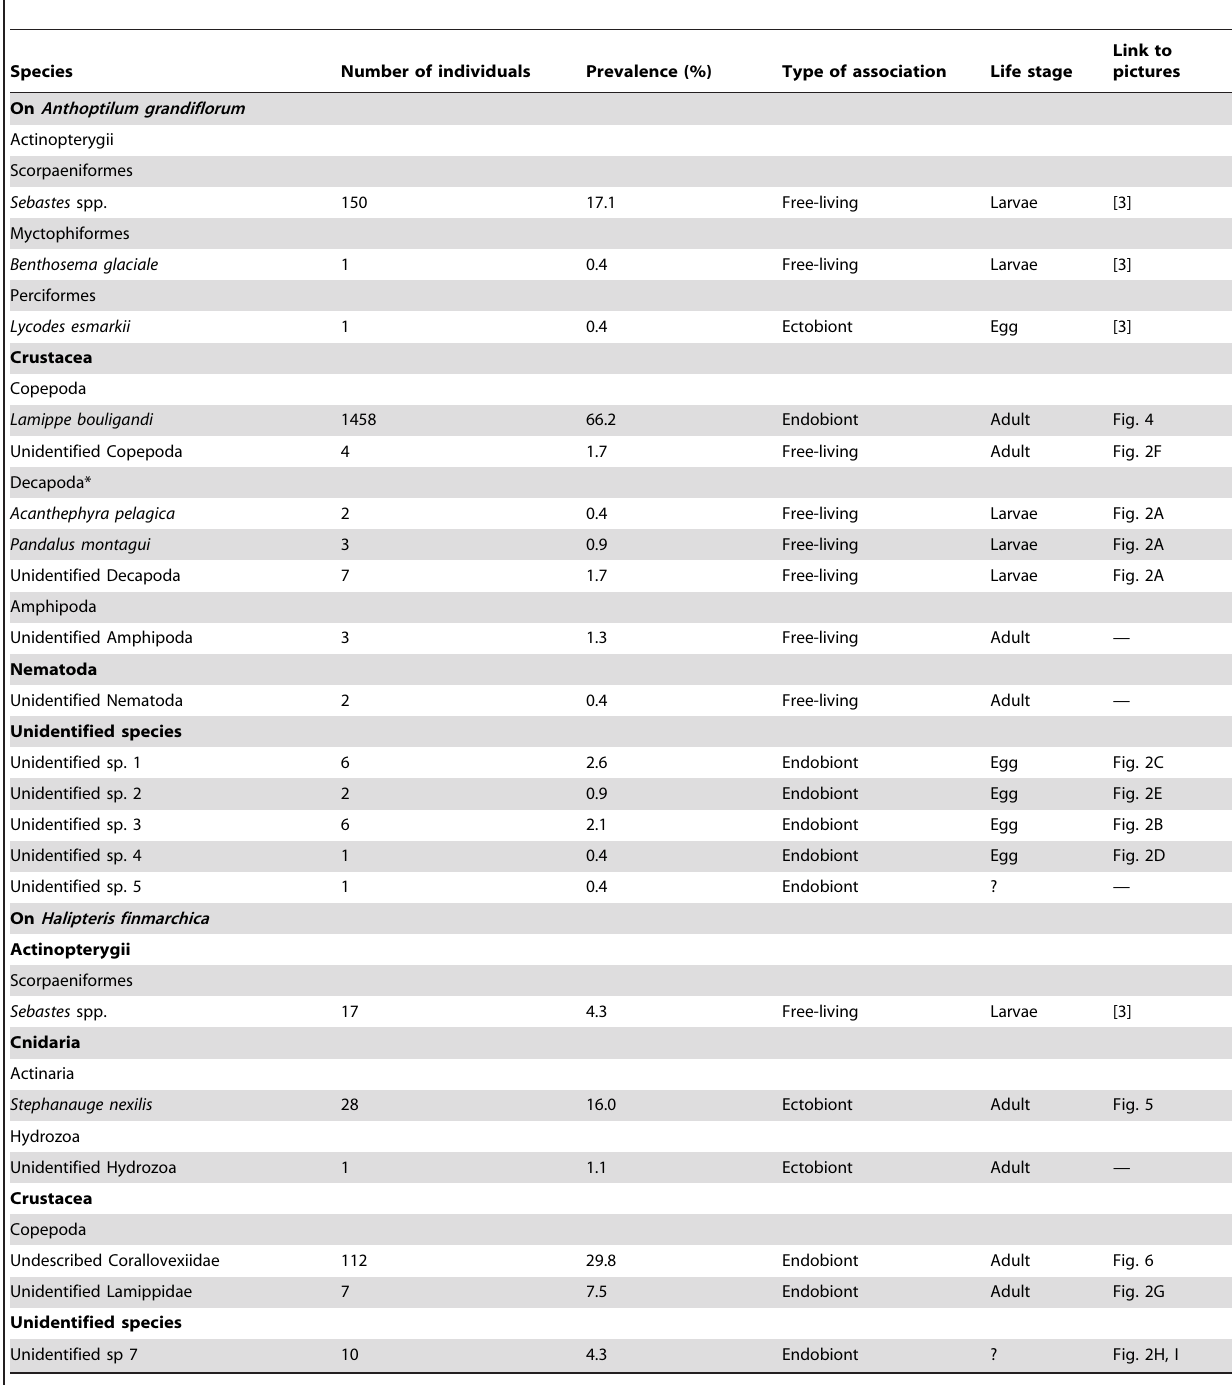
Table 2. Species found on the sea pens Anthoptilum grandiflorum and Halipteris finmarchica during the present study (2006–